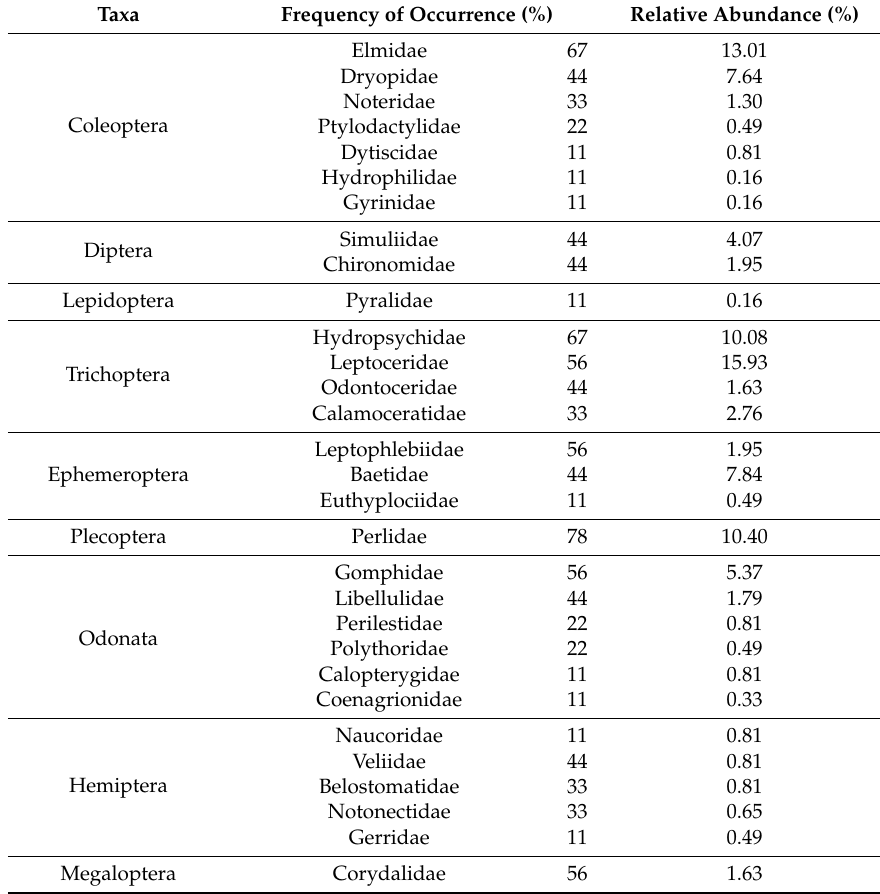
Table 3. Families of aquatic macroinvertebrates collected in nine streams at Taquaruçu Grande river basin, State of Tocantins,